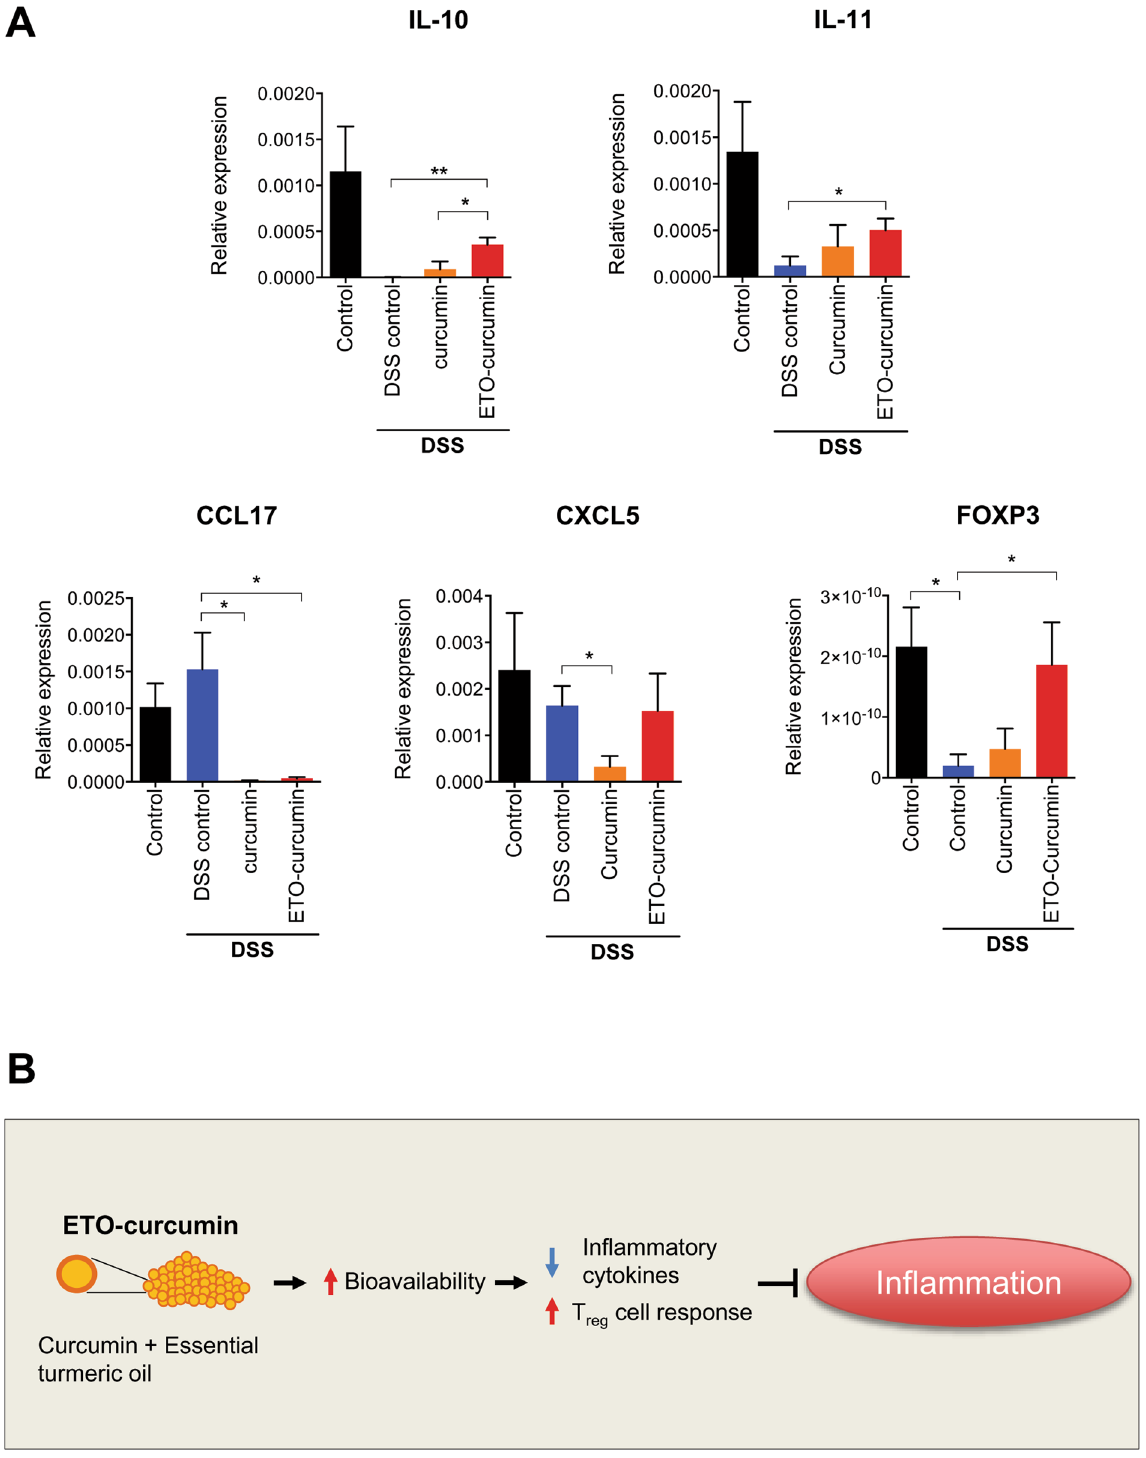
Figure 5. Curcumin suppresses inflammation through modulation of inflammation associated genes. ( A ) Gene expression of IL-10, IL-11, CCL17, CXCL5 and FOXP3 normalized to 18S ( B ) Schematic representation of how ETO-curcumin exerts its anti-inflammatory